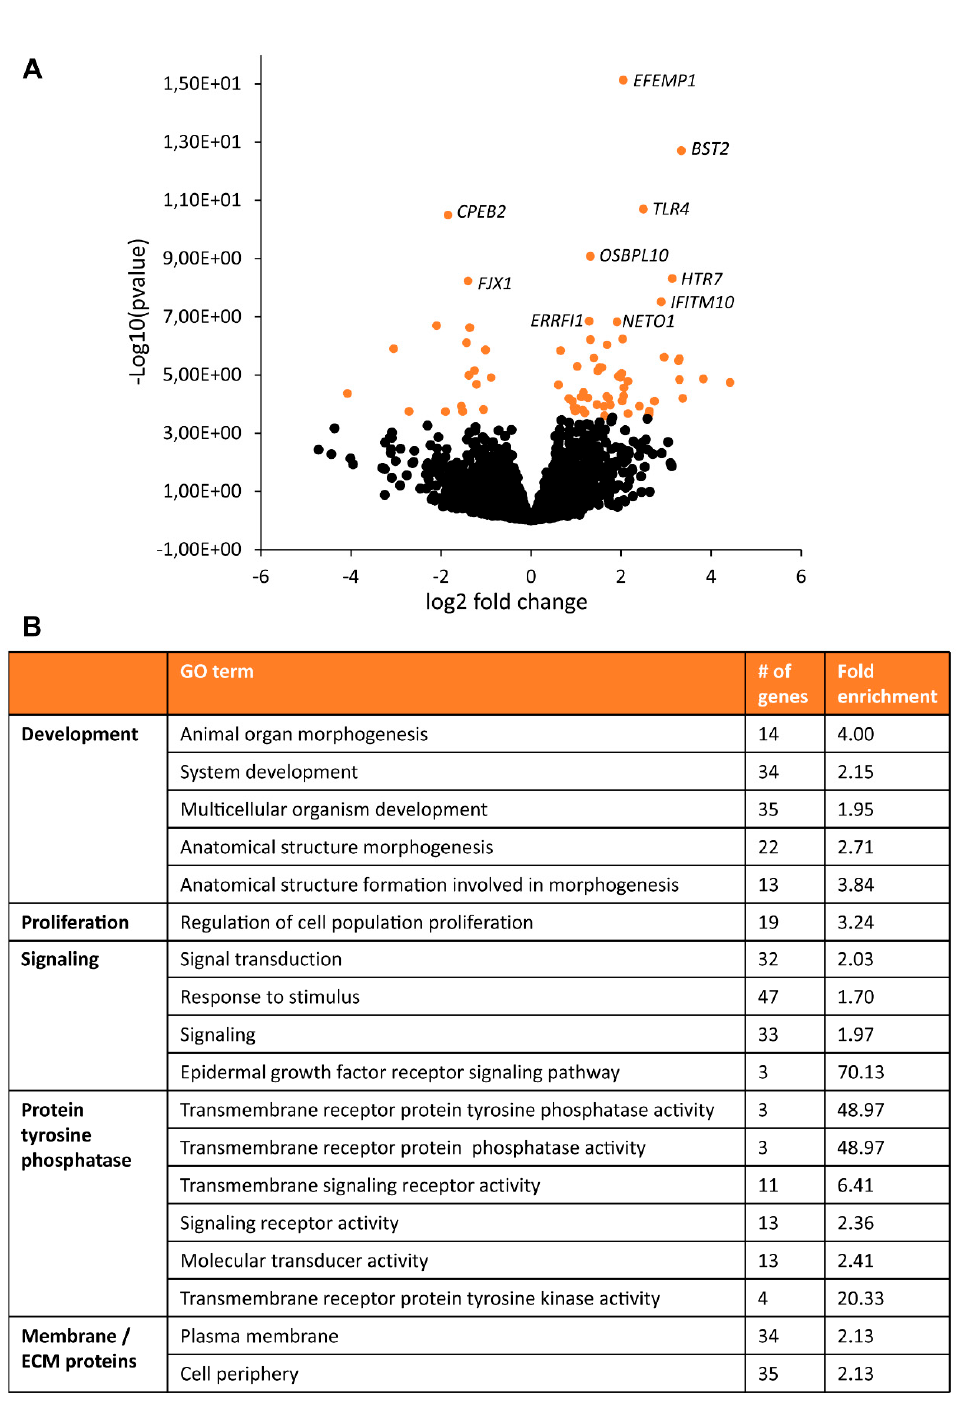
Figure 3. RNA sequencing of TSC astrocytes. RNA sequencing on day-60 control and TSC astrocytes showed 70 differentially expressed genes (DEGs). ( A ) Volcano plot with all significant genes in orange. The top 10 most significant genes are labeled with gene names. ( B ) Pathway enrichment analysis showed a number of enriched GO terms, which could be grouped into the domains “Development”, “Proliferation”, “Signaling”, “Protein tyrosine phosphatase” and “Membrane/ECM proteins”.